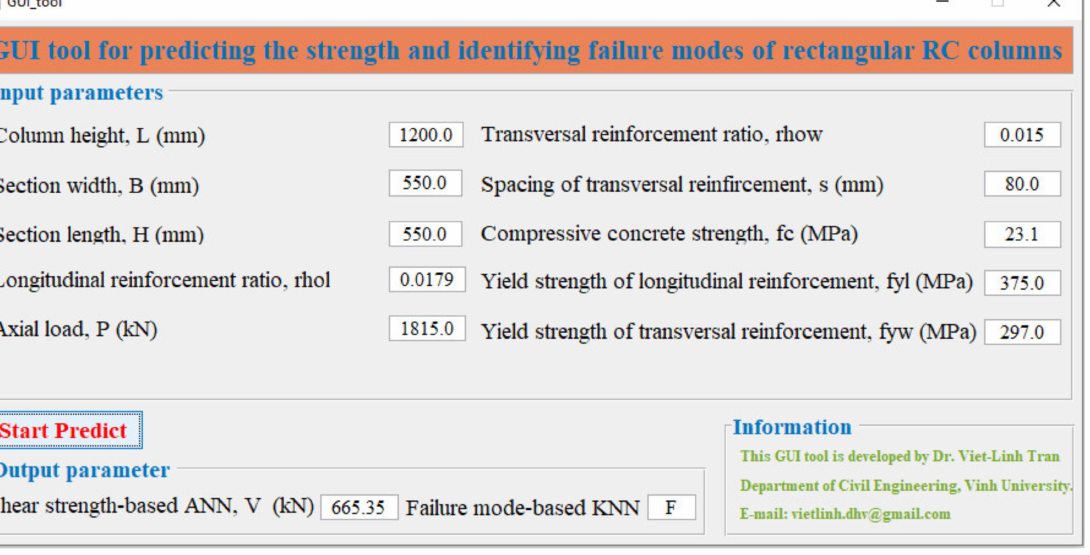
Figure 19. GUI for predicting the shear strength and identifying failure modes of rectangular RC